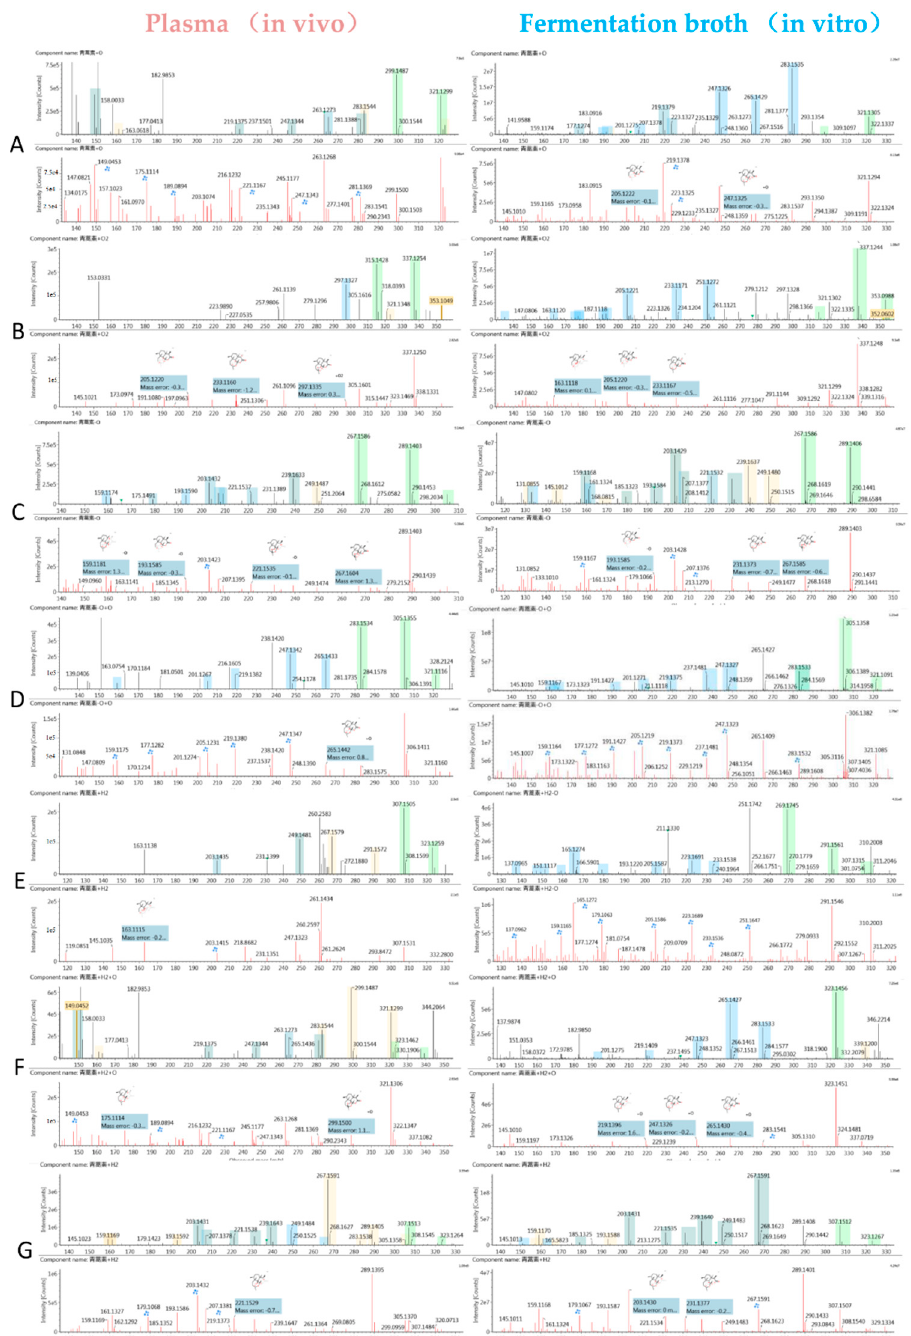
Figure 3. Ultra-performance liquid chromatography-electrospray ionization-quadrupole time-of-flight-mass spectrometry (UPLC-ESI-Q-TOF-MSE) spectra of metabolites in mouse plasma (left) and UPLC-ESI-Q-TOF-MSE spectra of metabolites in microorganisms (right) from the same sample and fragmentation sites in the high energy spectrum. ( A ) Monohydroxylation metabolite, ( B ) dihydroxylation metabolite, ( C ) deoxyartemisinin (de-ART), ( D ) deoxygenation followed by hydroxylation metabolite, ( E ) dihydroartemisinin (DHA) and deoxygenated DHA, ( F ) hydrogenated DHA, and ( G ) hydrogenation followed by deoxidization of DHA. A blue box behind the low-energy fragment ions shows in-source fragment ions and a green box indicates adduct clusters.